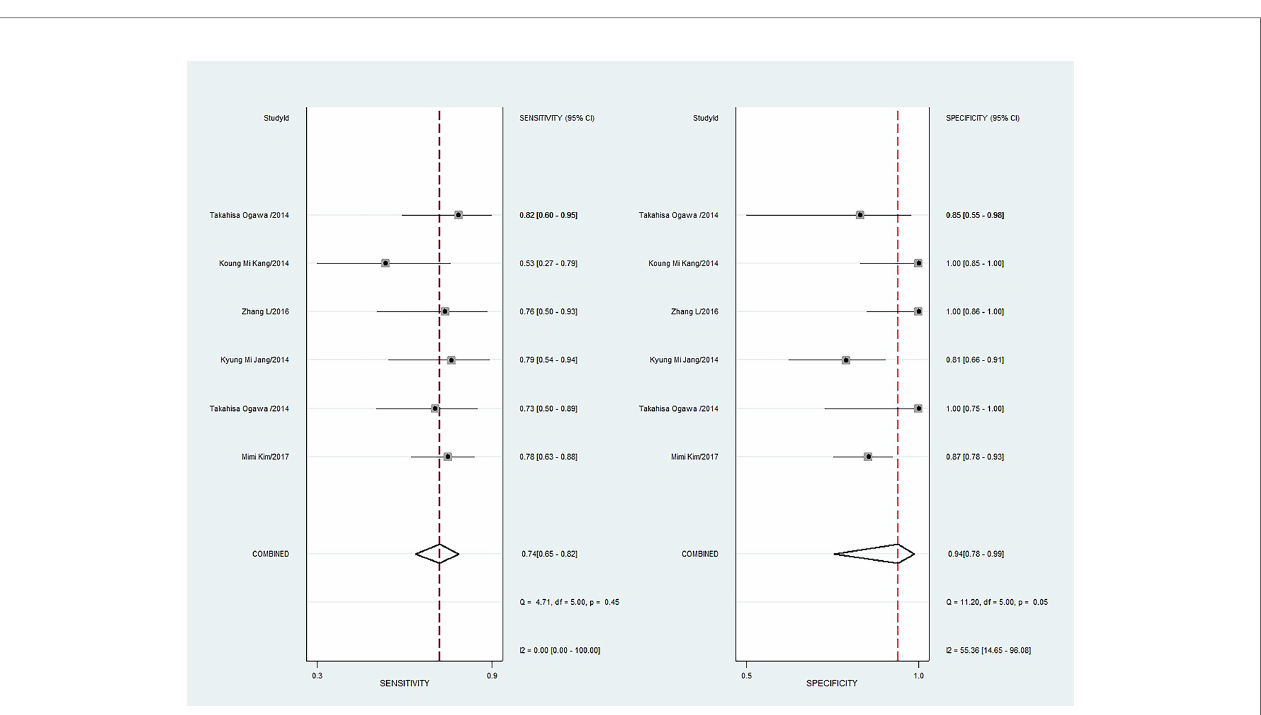
FIGURE 3 | Coupled forest plots of pooled sensitivity and speci fi city. Numbers are pooled estimates with 95% con fi dence intervals (CIs) in parentheses and horizontal lines indicate 95%